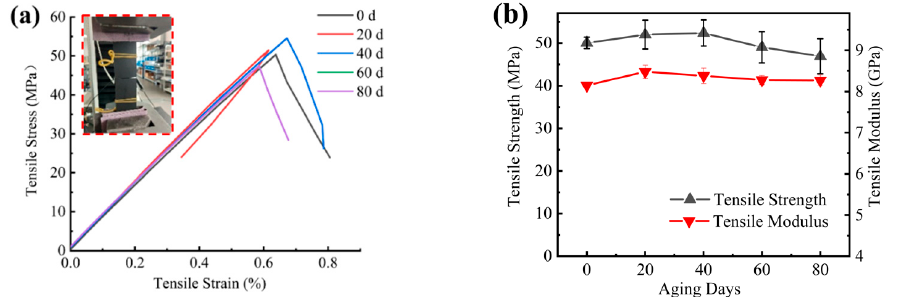
Figure 14. ( a ) Transversal direction tensile stress–strain curve; ( b ) transversal direction tensile strength/modulus versus aging time curve.